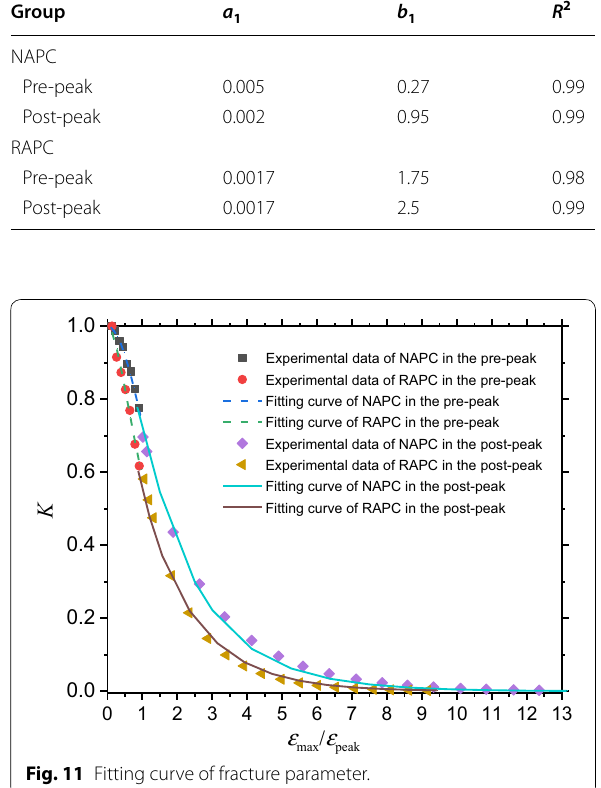
Fig. 11 Fitting curve of fracture